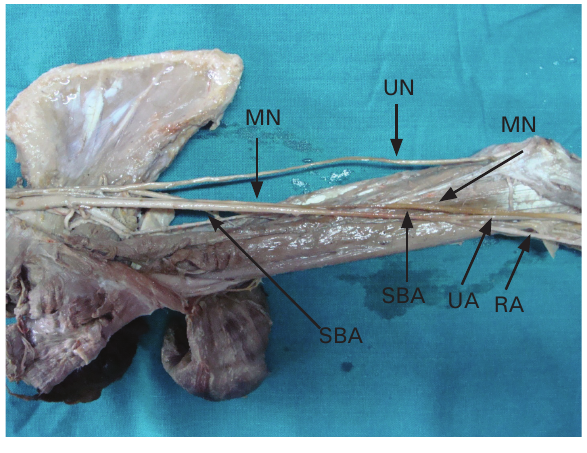
Figure 1. Showing Superficial Brachial artery and its high division.